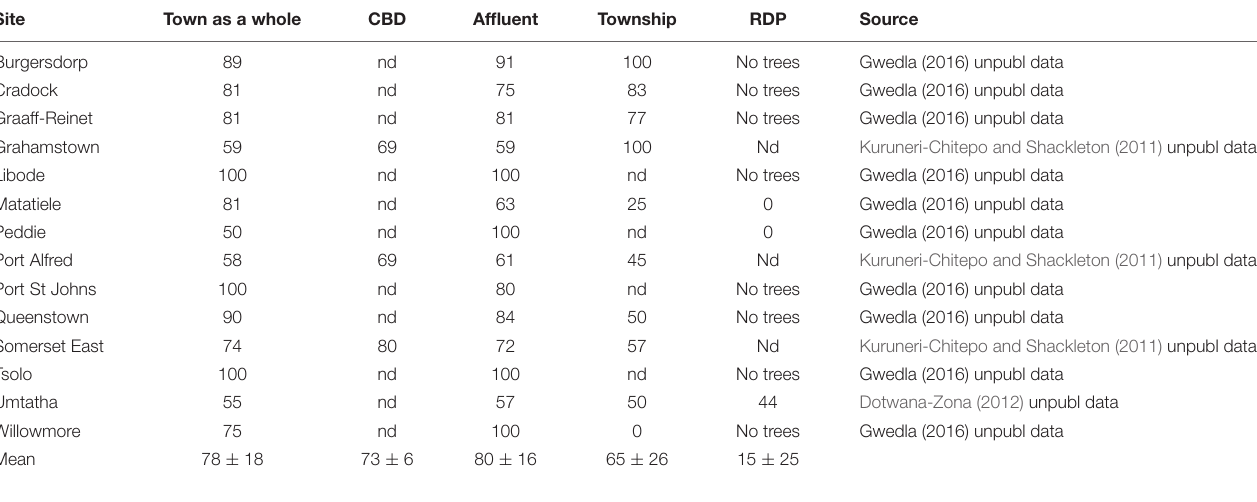
TABLE 1 | The proportion (%) of non-native street trees species in 14 towns and neighborhoods in the Eastern Cape, South Africa (nd, no data) (towns were selected by the original studies, and all studies reporting street tree composition in the province have been